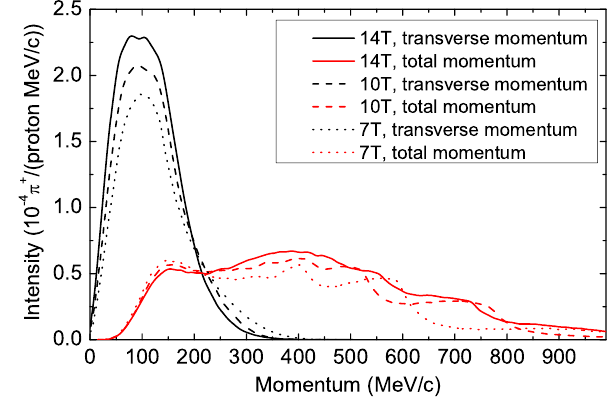
FIG. 9. Magnetic field pattern on axis along the field tapering section.